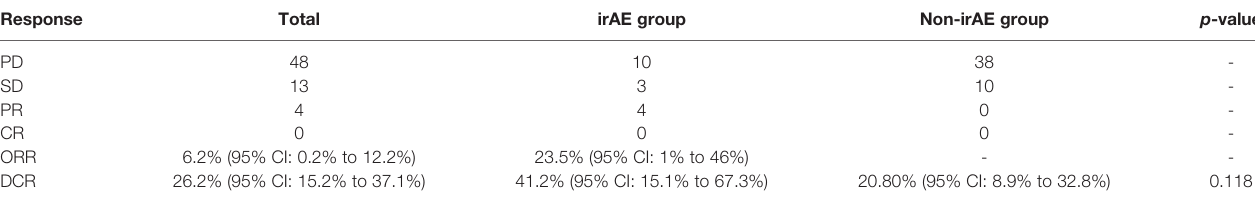
TABLE 2 | Response to